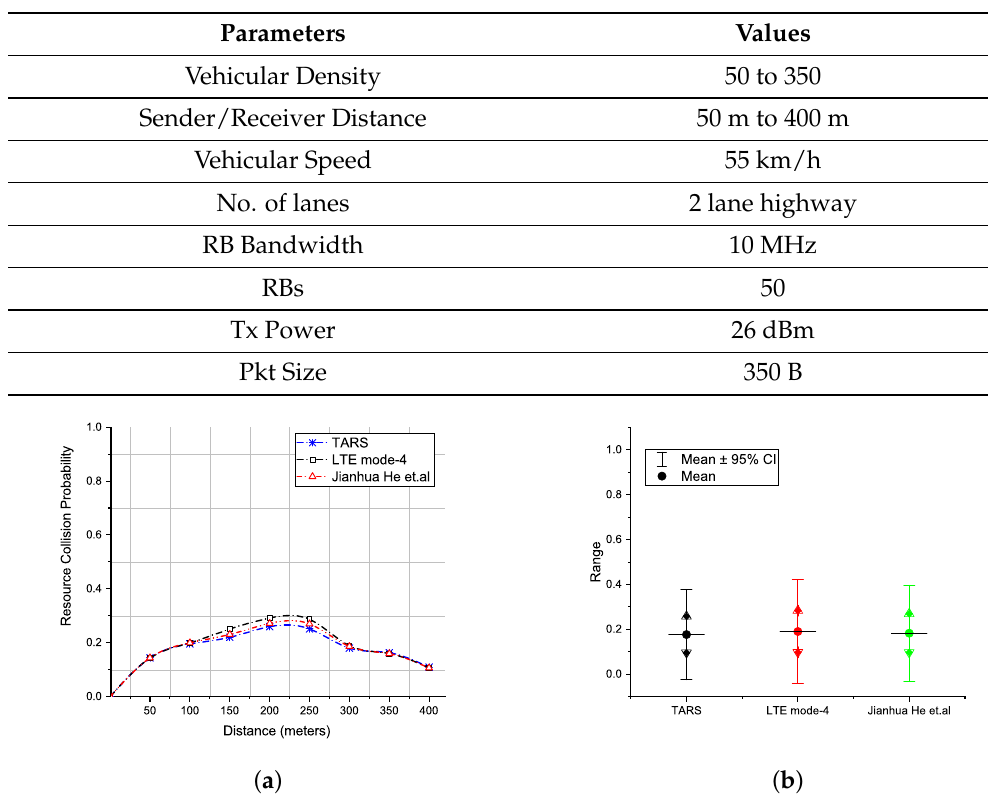
Table 2. Parameters.